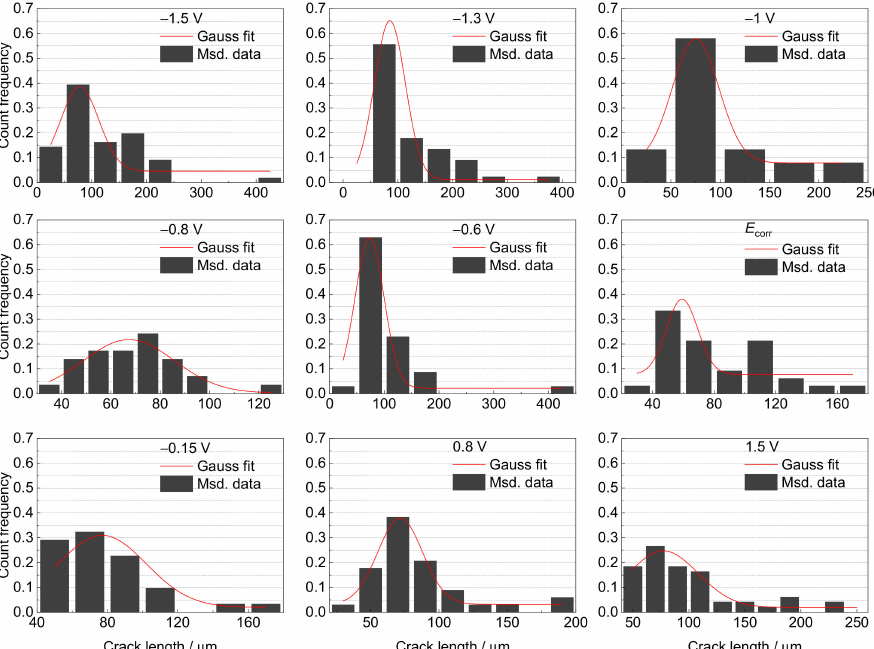
Figure 13. The distribution of secondary crack length near the main crack at various potentials in a simulated shallow–sea